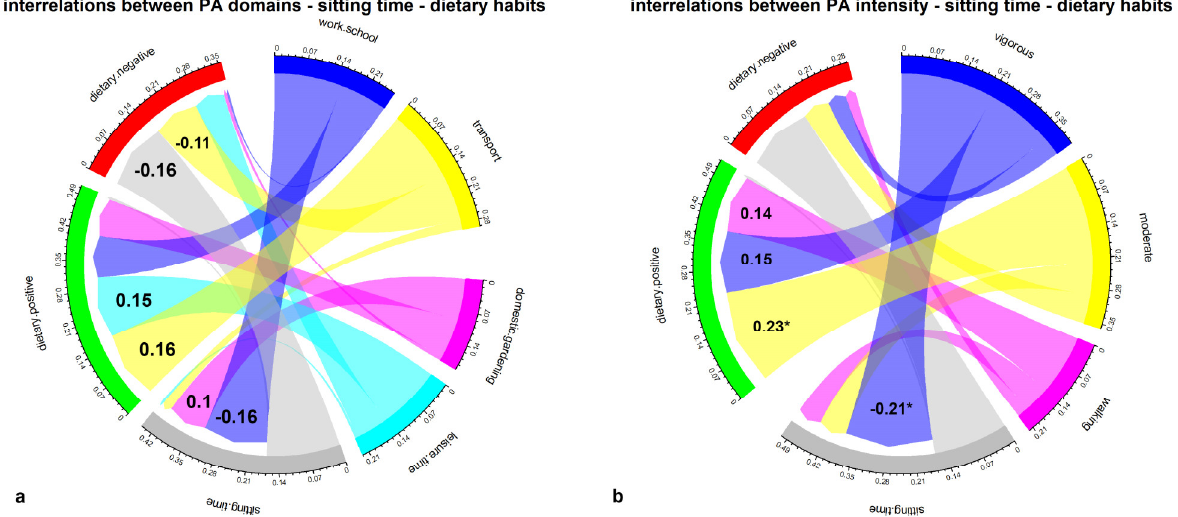
Figure 2. ( a , b ) Chord diagrams of the Pearson correlations between: ( a ) PA domains, sitting time, and dietary healthy (positive) and unhealthy (negative) behaviors in adolescents; ( b ) PA intensity, sitting time, and dietary healthy (positive) and unhealthy (negative) behaviors in adolescents. The width of the links is proportional to the strength of the correlation. * p < 0.05.